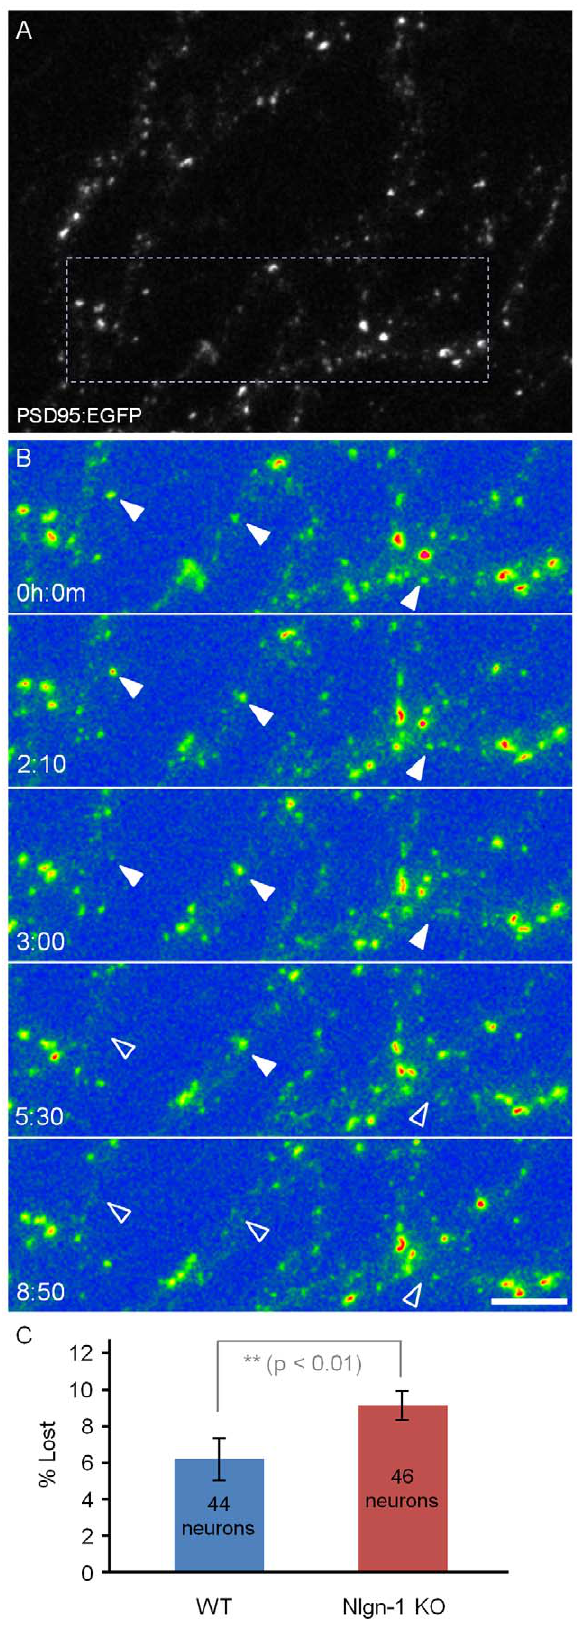
Figure 4. PSD-95:EGFP puncta loss rate. A ) Dendrites of a neuron from a Nlgn-1 KO mouse expressing PSD-95:EGFP (21 days in vitro ). B ) Time lapse sequence of region enclosed in rectangle in A. Full arrowheads point to PSD-95:EGFP lost over time (empty arrowheads). Fluorescence intensities shown in false color. C ) Fractional loss rates (% lost over 12 hour periods) in neurons from Nlgn-1 KO mice and WT